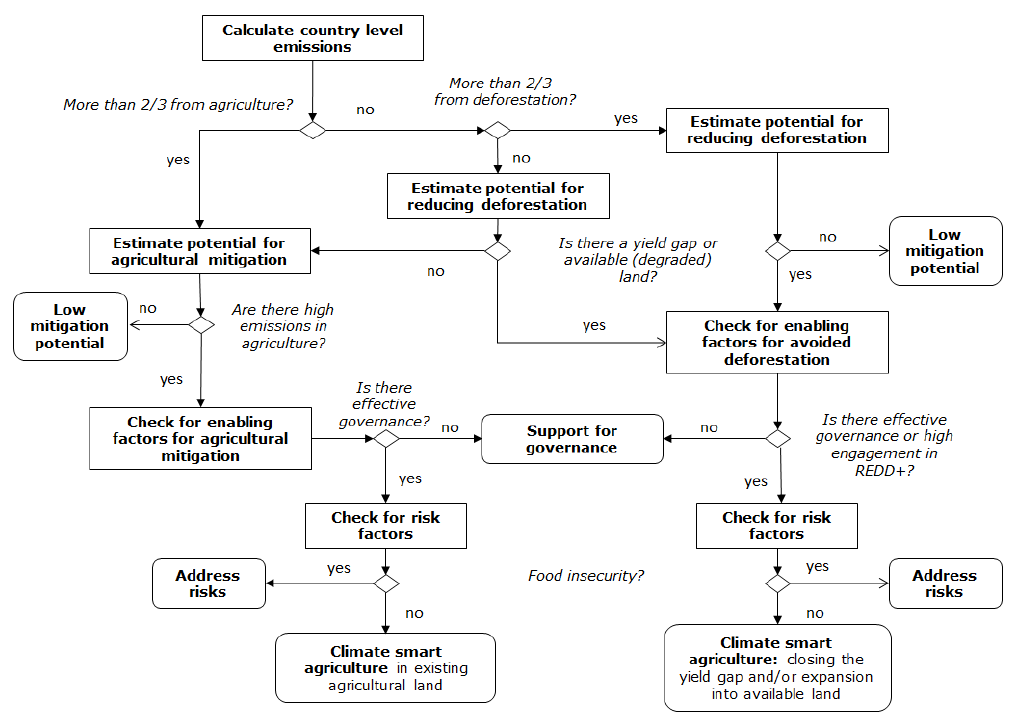
Figure 2. Decision tree to identify priority areas for mitigation interventions. Data required for decision making are described in Table